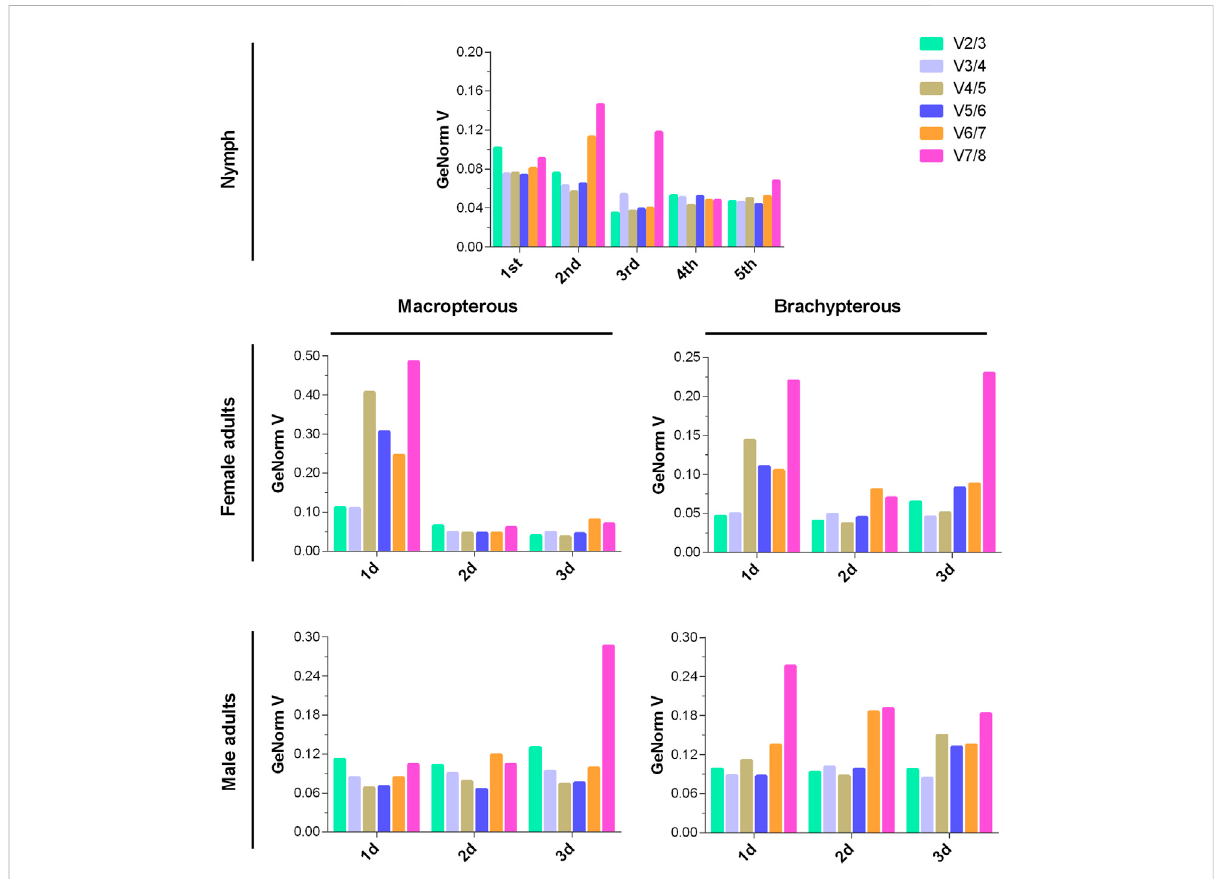
FIGURE 2 The optimal number of reference genes required for accurate normalization of gene expression of N. lugens under the hypomagnetic fi eld versuslocalgeomagnetic fi eldbyGeNorm.Thepairwisevariations(Vn/n+1)werecalculatedbetweennormalizationfactorsNF n andNF n+1 .TheVn/ n + 1 value below 0.15 indicates that the addition of the n + 1 reference gene makes no signi fi cant contribution to the